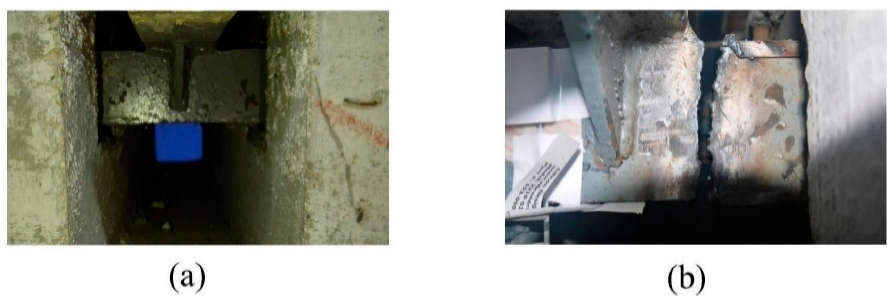
Figure 5. Support bar of the specimens: ( a ) healthy support bar; ( b ) damaged support bar.